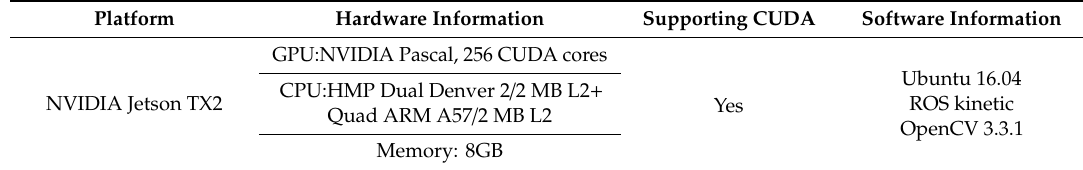
Table 1. Experimental hardware and software